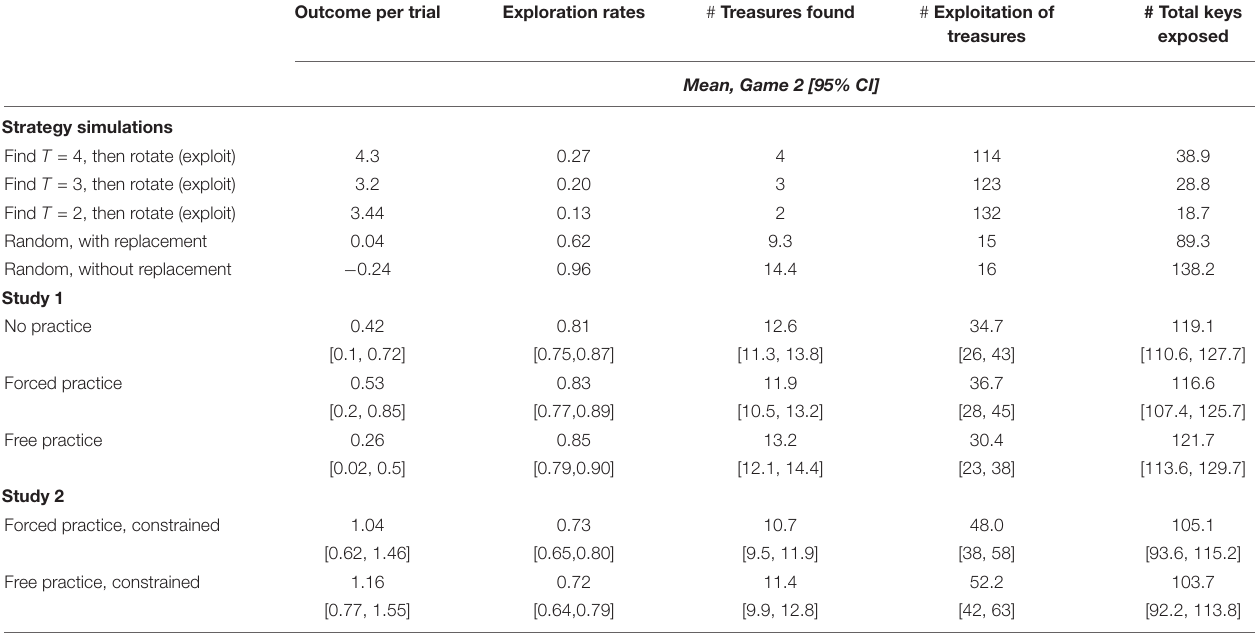
TABLE 2 | Descriptive results of Game 2 in simulations and Conditions observed in Studies 1 and 2. Outcome per trial Exploration rates # Treasures found